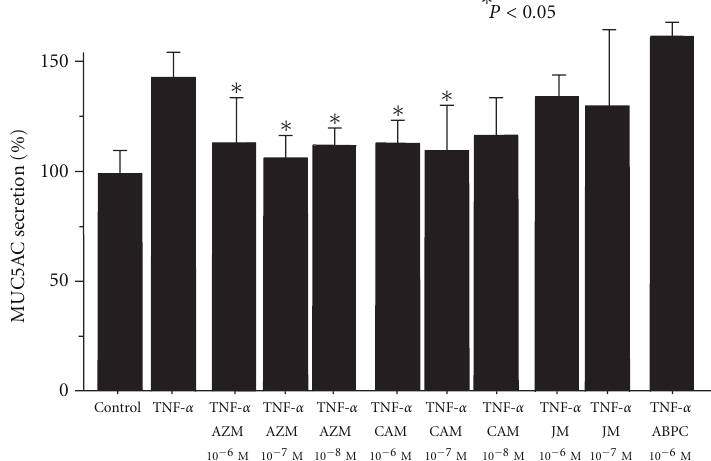
Figure 3: E ff ects of azithromycin (AZM), clarithromycin (CAM), josamycin (JM), and ampicillin (ABPC) on TNF- α (20ng/mL)-induced MUC5AC secretion from NCI-H292 cells ( n = 5). TNF- α stimulated mucin secretion. AZM and CAM significantly inhibited TNF- α -induced MUC5AC secretion, whereas JM and ABPC had no e ff ect.